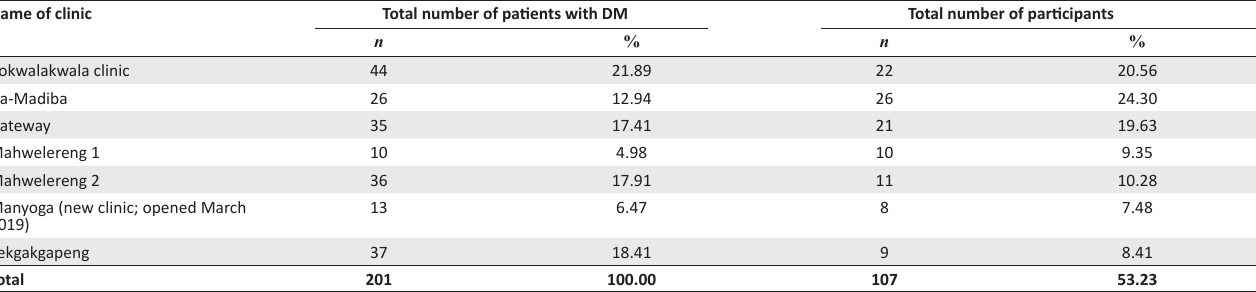
TABLE 1: Database of 201 patients with diabetes mellitus and number of participants (107) who consented to participate in the screening programme. Name of clinic